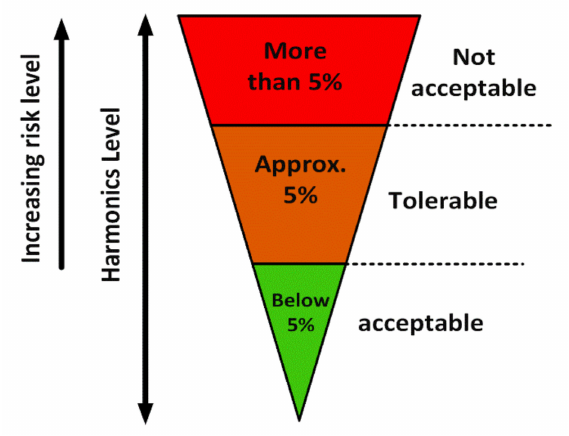
Figure 9. As low as reasonably practicable (ALARP) diagram of harmonics